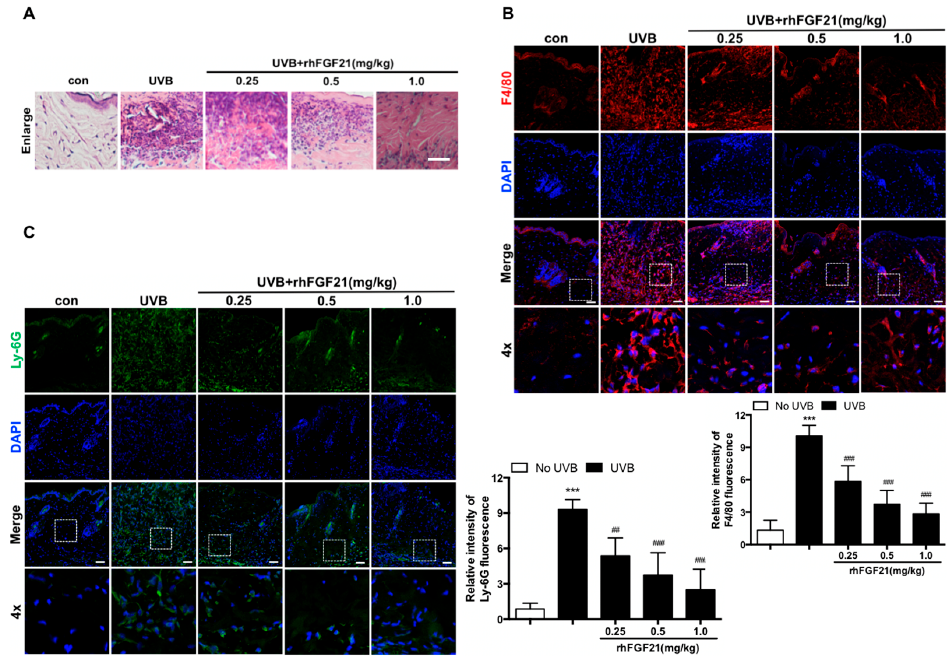
Figure 2. RhFGF21 inhibited inflammatory cell infiltration in UVB-irradiated mouse skin. ( A ) HE staining (n = 4). Scale bar = 25 μ m. Local enlarged picture in HE staining (Figure 1E). ( B , C ) Immunofluorescence confocal microscopy images of F4/80 and Ly-6G in UVB-irradiated mouse skin tissues. Scale bar = 100 μ m. The Data are presented as means ± SD. *** p < 0.001 versus mice without UVB-irradiation exposure; ## p < 0.01, ### p < 0.001 versus UVB-irradiated mice. The data are presented as means ± SD. *** p < 0.001 versus mice without UVB irradiation exposure; ## p < 0.01, ### p < 0.001 versus UVB-irradiated mice.